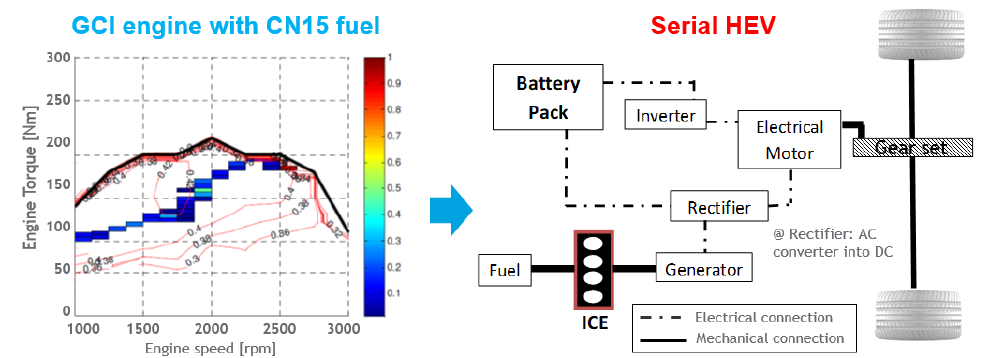
Figure 11. Energy-weighted operating point distribution of CN15 engine on WLTC and serial hybrid configuration.